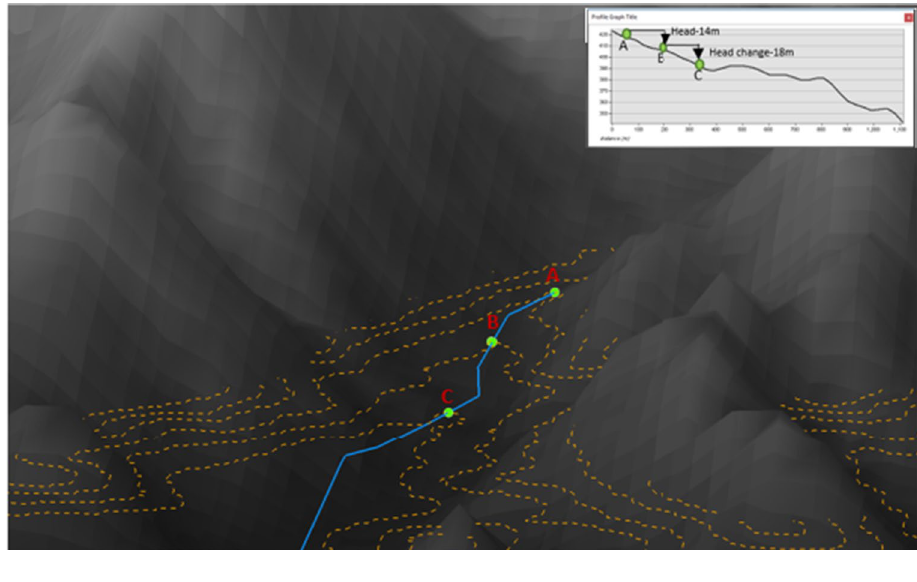
Fig. 4 Head drop: inset: profile sketch of the river channel at 100 m